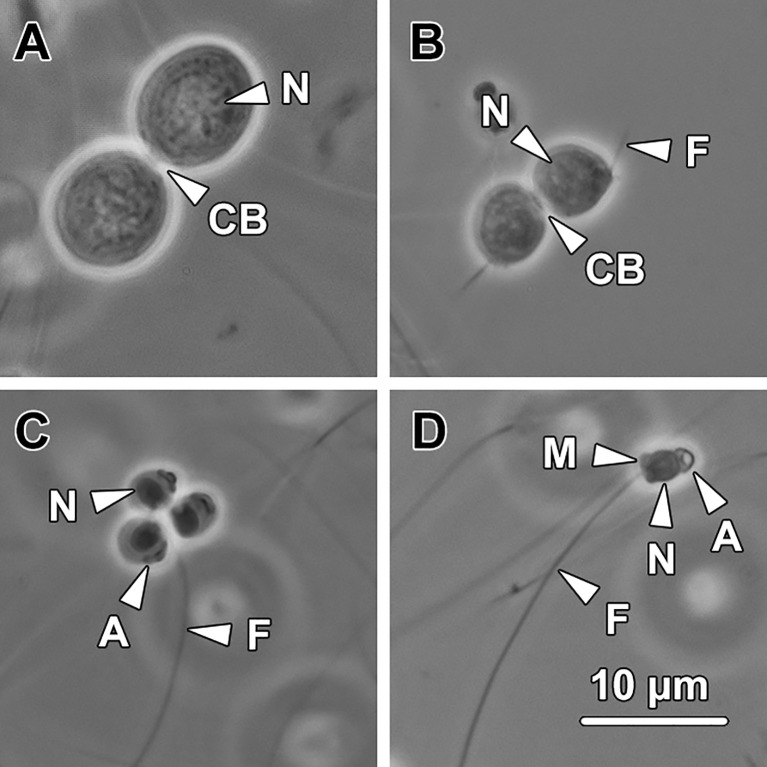
Representative types of spermatids and spermatozoa in the culture media.(A) Step 1–3 spermatids. The spermatids at these steps are spherical to oval in shape. They are in pairs and interconnected by a cytoplasmic bridge (CB). N, nucleus. (B) Step 4–6 spermatids. Spermatids at these stages remain connected by a cytoplasmic bridge (CB) however a short flagellum (F) protrudes from the posterior end of each spermatid. N, nucleus. (C) Step 7–9 spermatids. The spermatids at these steps are spherical and contain a cap-like acrosome (A), a condensed nucleus (N) and an elongated flagellum (F). The acrosome resides at or near the posterior end of the spermatids. (D) Spermatozoa. Spermatozoa consist of a cap-like acrosome (A), an oval nucleus (N), a short midpiece (M) and a flagellum (F).